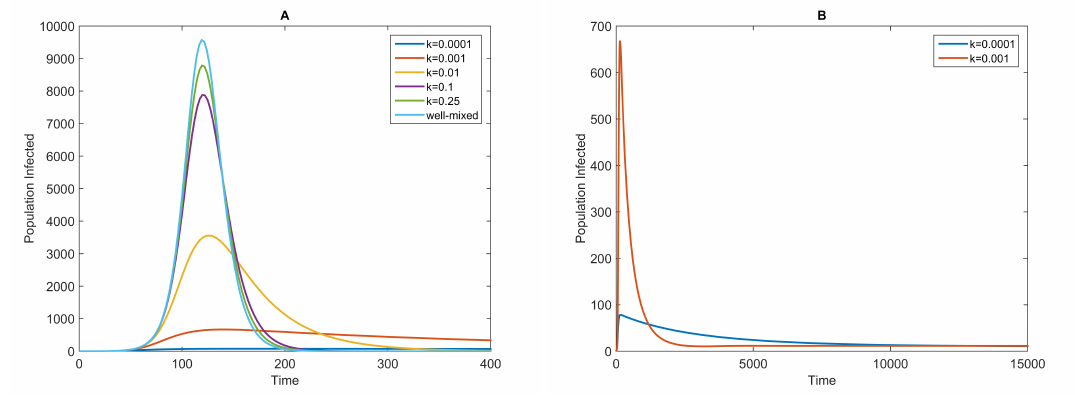
Figure 2. Infectious curves for different values of k and fixed β for the negative binomial distribution (NBD) model (Equation (4)). The values of k are shown in the legend. The other parameters are = 7 days, 1 = 5 days and 1 = 70 years. The initial conditions are as follows: β = 0.5, 1 α γ µ S ( 0 ) = 99,999, E ( 0 ) = 0, I ( 0 ) = 1 and R ( 0 ) = 0. The top curve in ( A ) is the infectious curve of the homogeneous-mixing model with a frequency-dependent transmission term [4]; it is compared to the infectious curves of the NBD model; ( B ) The long trend of the infectious curves of the NBD model with k = 0.0001 and k =